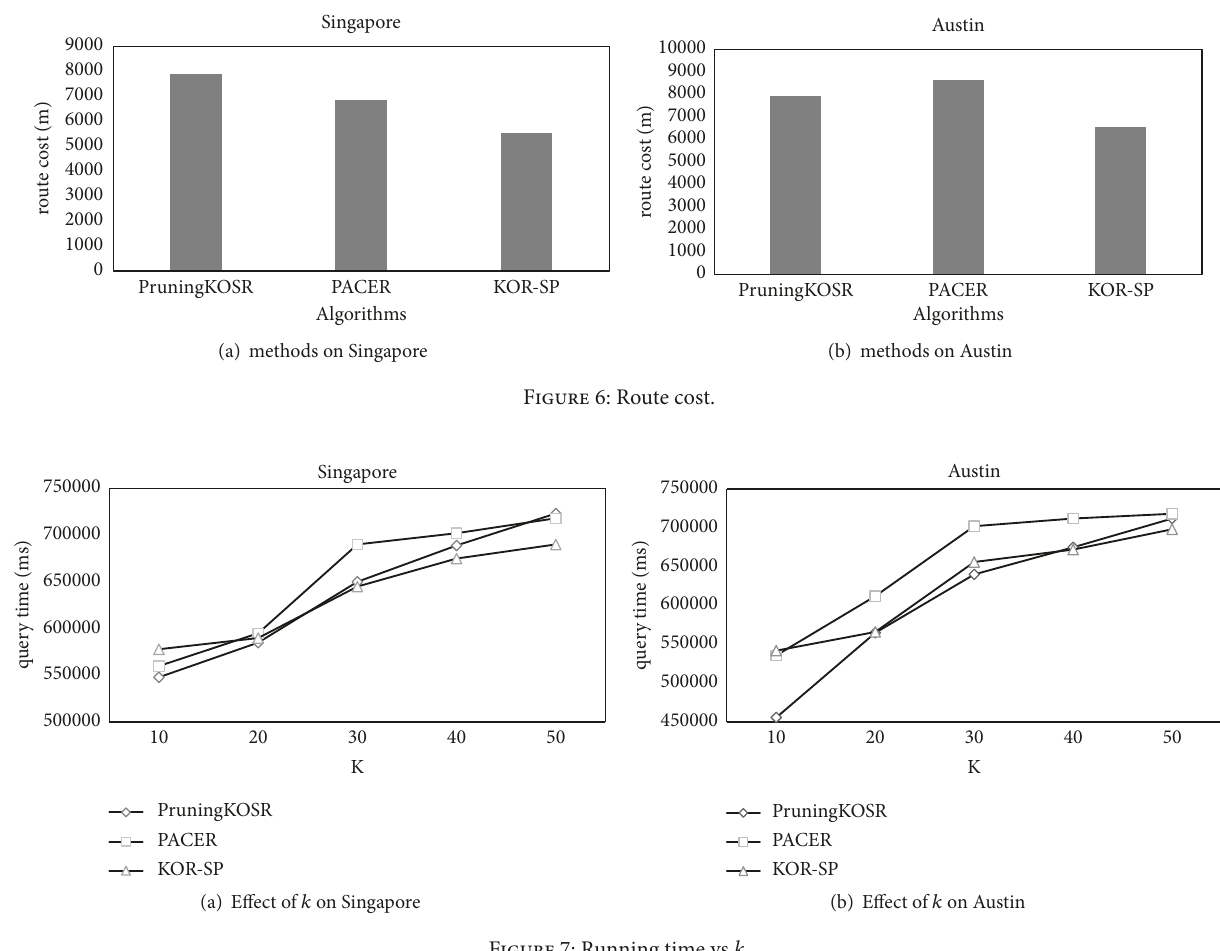
Figure 7: Running time vs.